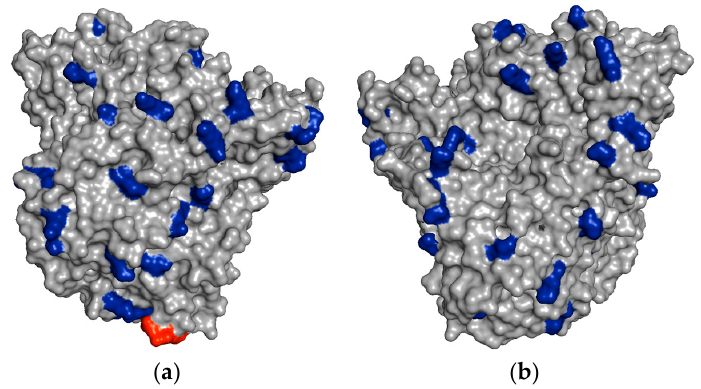
Figure 4. Vicinal Lys residues on the PGA surface. Lys residues are colored in blue and N-terminal is colored in red. ( a ) Front-side view of the PGA; ( b ) Back-side view of the PGA. The 3D structure was obtained from the Protein Data Bank (PDB) using PyMol v. 1.74. The PDB code for PGA is 1PNK.